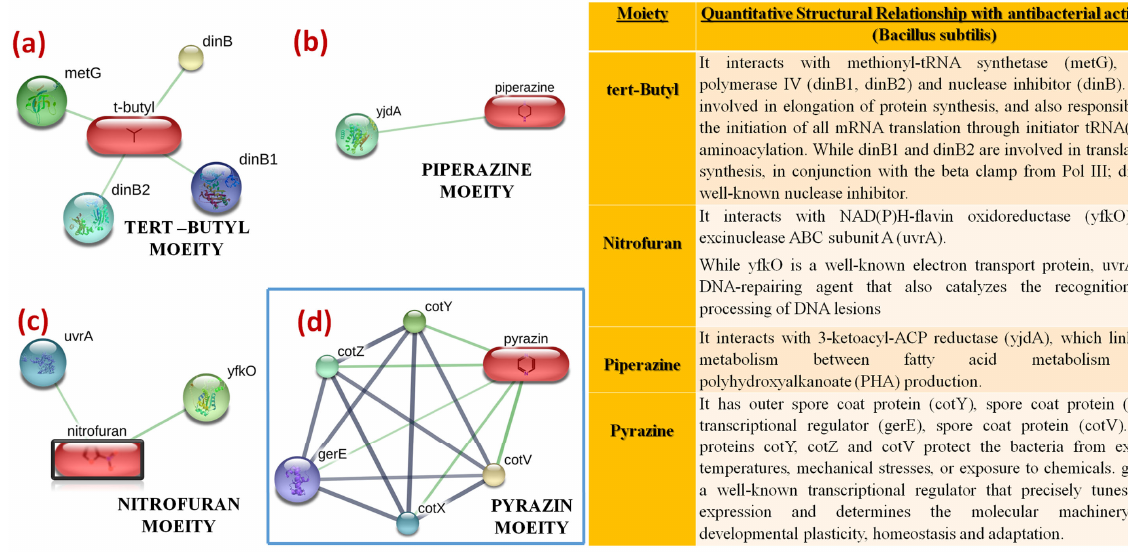
Figure 7. Quantitative biological relationships of various moieties of oxazolidinones ( a ) tert-Butyl moiety ( b ) Piperazine moiety ( c ) Nitrofuran moiety ( d ) Pyrazine moiety